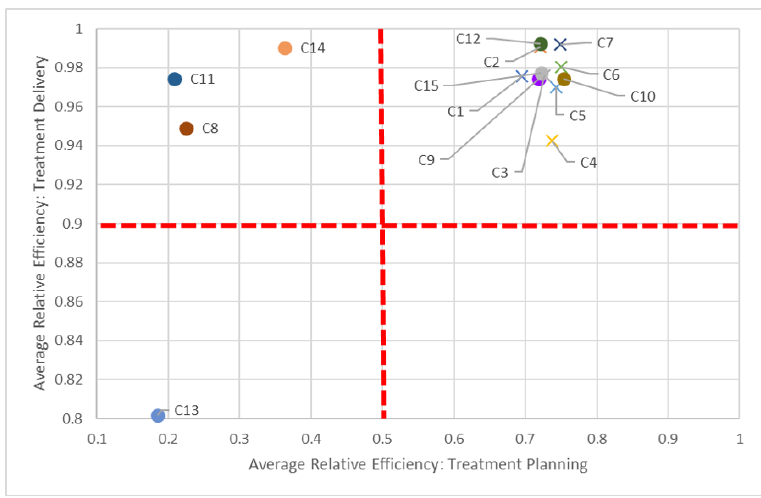
Figure 6. Benchmarking according to planning and delivery dimensions (2016).